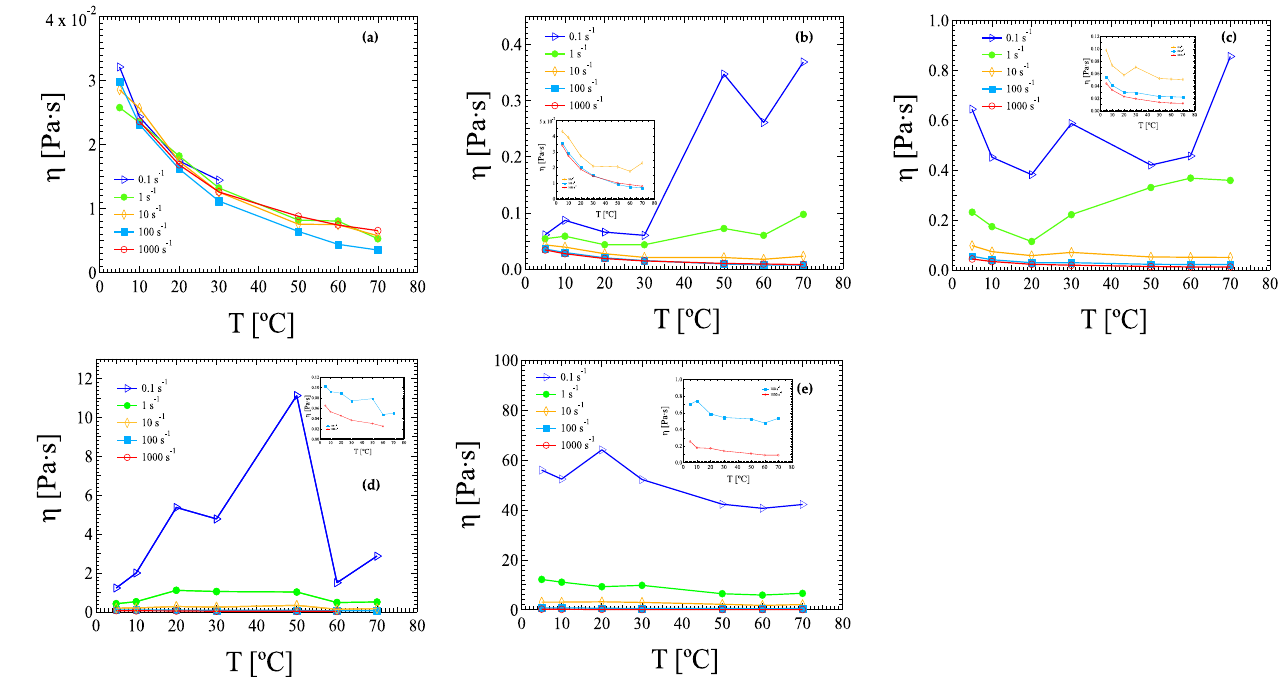
Figure 4 . Viscosity dependence on temperature of inks and pastes with HRCM loads of: ( a ) 0.08, ( b ) 0.16, ( c ) 0.40, ( d ) 0.80, and ( e ) 2.40 wt%. Data are extracted from flow curve measurements carried